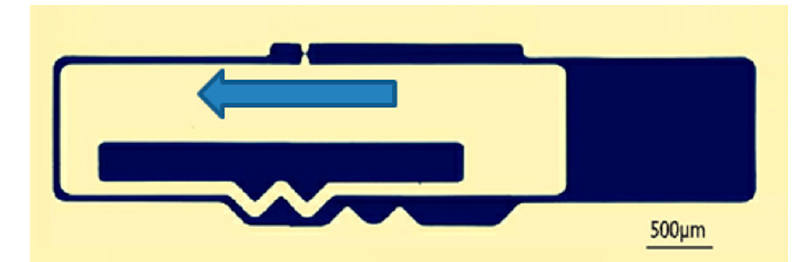
Figure 14. The direction of impact acceleration.